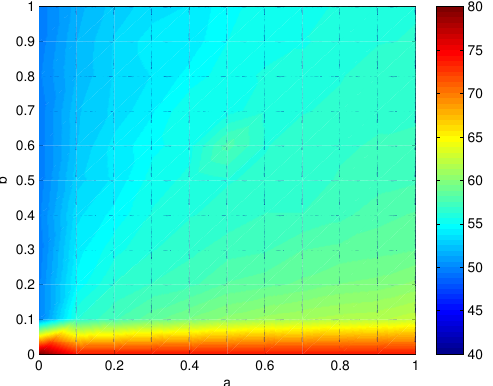
Figure 8. The relation between a , b and the number of generated connected cover sets.